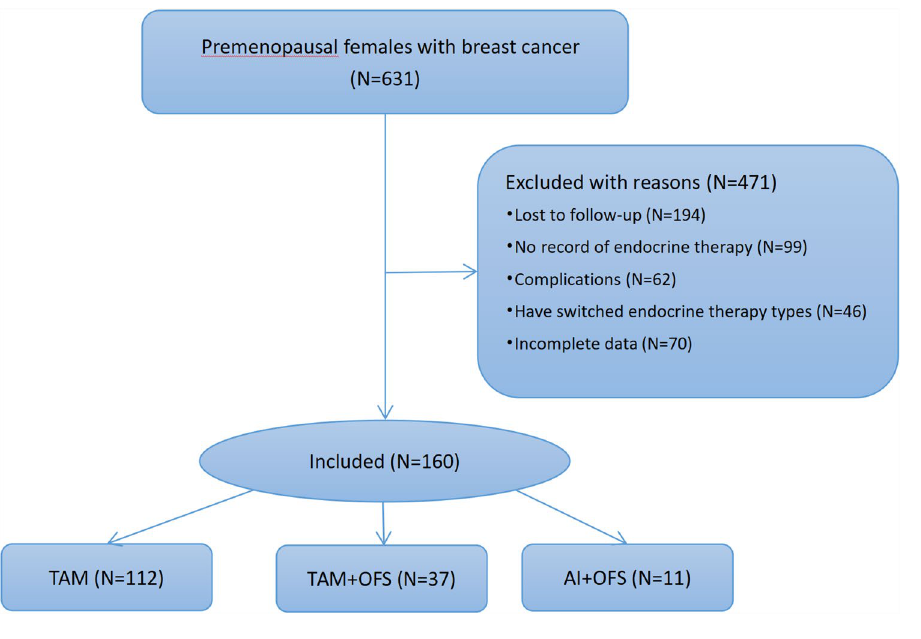
Figure 1. Review the process of